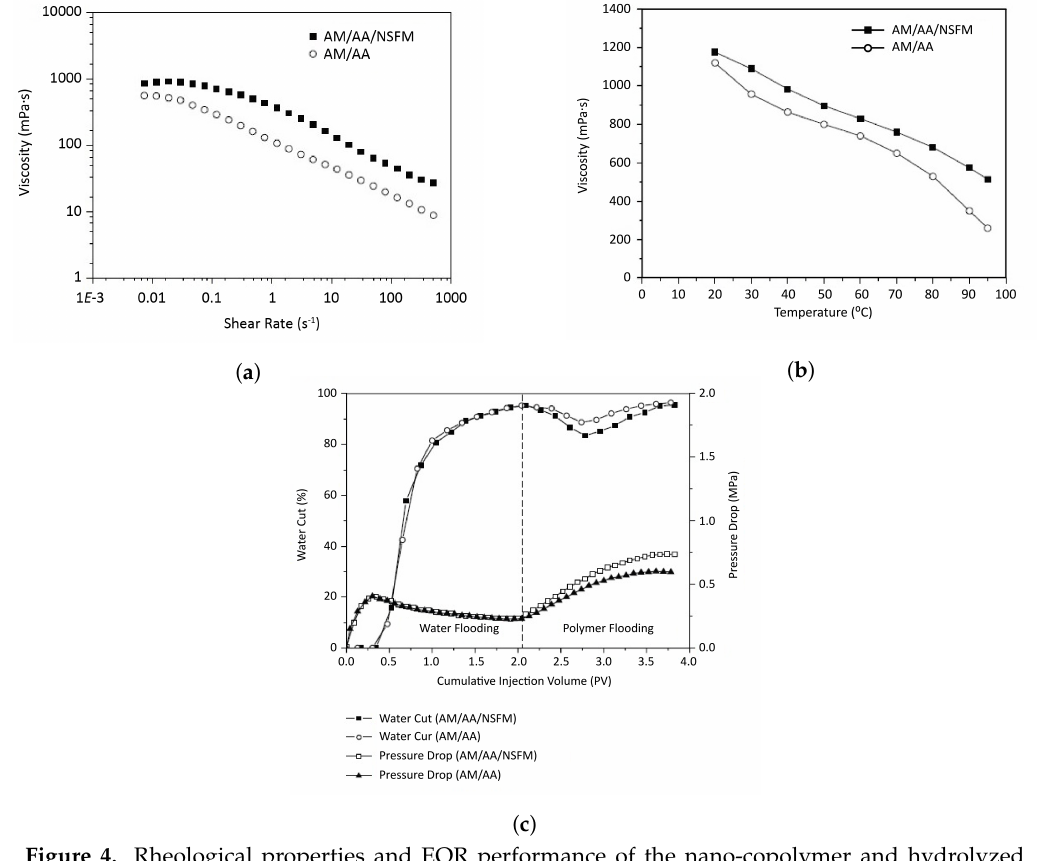
Figure 4. Rheological properties and EOR performance of the nano-copolymer and hydrolyzed polyacrylamide (HPAM). Effect of shear rate on viscosity for polymer solutions (0.2 wt%) prepared with distilled water ( a ); viscosity versus temperature for HPAM and AM/AA/NSFM solutions (0.5 wt%) ( ˙ γ = 7.34 s − 1 ) ( b ); and core flooding experimental results of AM/AA/NSFM and HPAM (0.2 wt%) at 65 °C ( c ). Figure reproduced from Ref. [63]. AM/AA/NSFM: acrylamide/acrylic acid/nano-SiO 2 functional